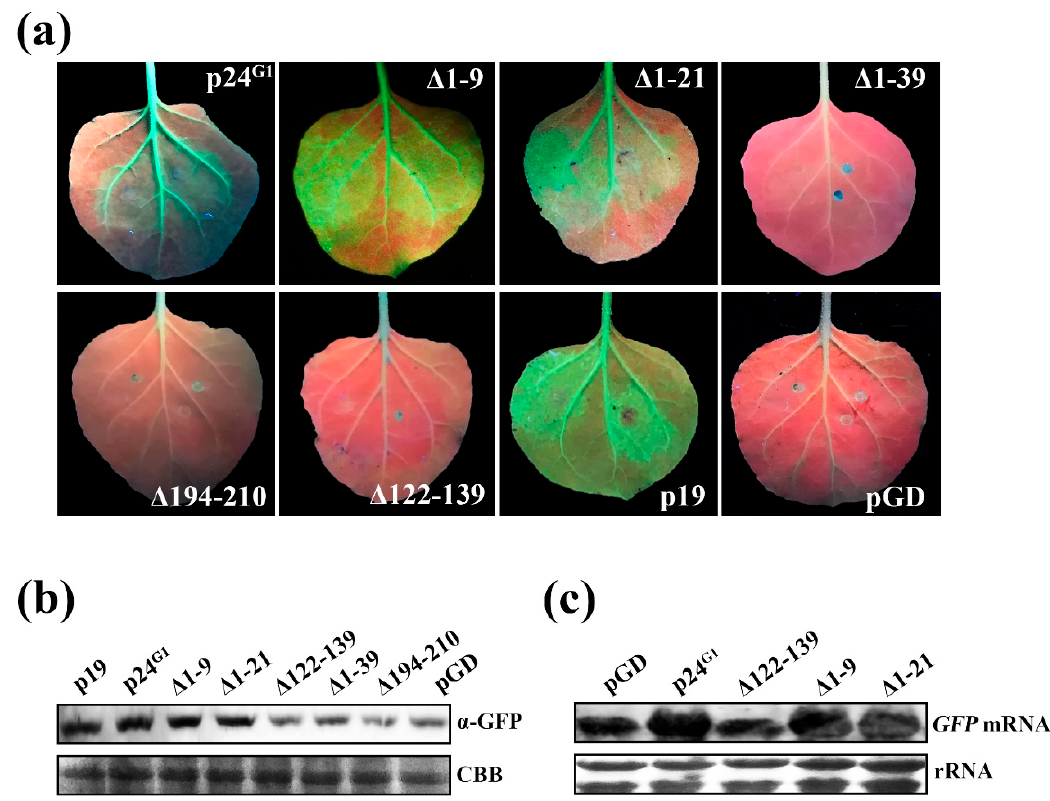
Figure 6. Analysis of silencing suppression activity of p24 of grapevine leafroll-associated virus 1 (p24 G1 ) mutants. ( a ) GFP images of agroinfiltrated patches of N. benthamiana line 16c under UV at 3 dpi, infiltrated with a mixture of Agrobacterium cultures containing pGD–GFP and a plasmid expressing the indicated proteins. Each indicated GFP image is representative of more than 15 individual leaf samples from three separate experiments. Coinfiltration of pGD–GFP and the empty vector pGD or pGD–p19 was used as negative or positive control. ( b ) GFP protein accumulation detected by Western blot using anti-GFP antibody. ( c ) Northern blot analysis of GFP mRNA using DIG-labeled probes. Total protein ( b ) and RNA ( c ) were extracted from the agroinfiltrated patches at 3 dpi. CBB staining ( b ) and Ethidium-bromide-stained rRNA ( c ) served as loading controls.